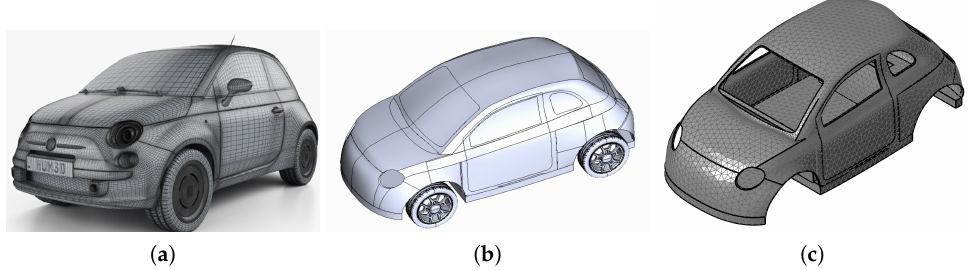
Figure 1. Commercial CAD model of a FIAT 500 ( a ), simplified CAD model for electromagnetic simulations ( b ), and the surface mesh used in this paper ( c ).